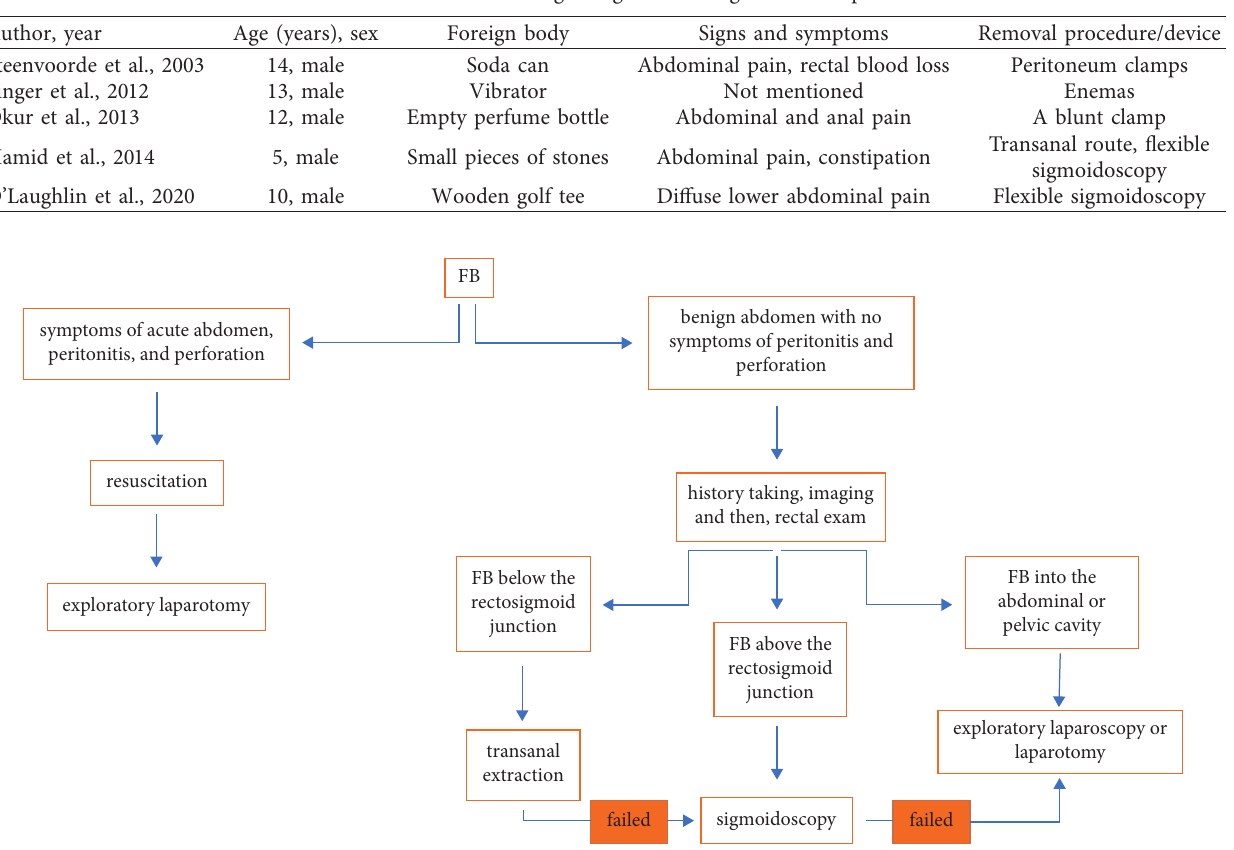
Figure 3: A simplified management algorithm for rectal foreign bodies; FB, foreign